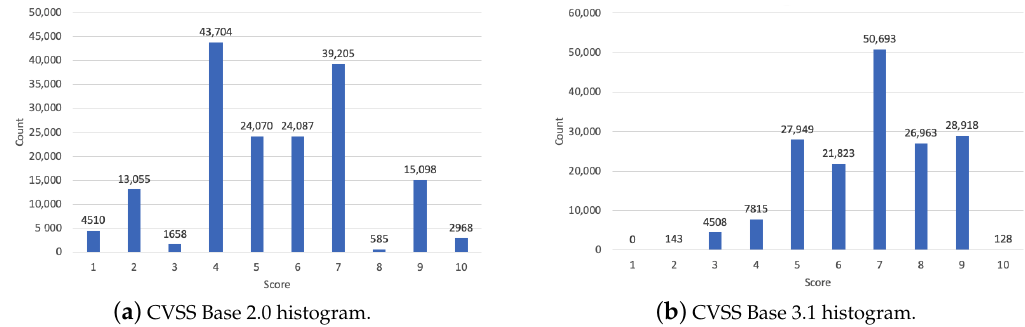
Figure 2. CVSS Base